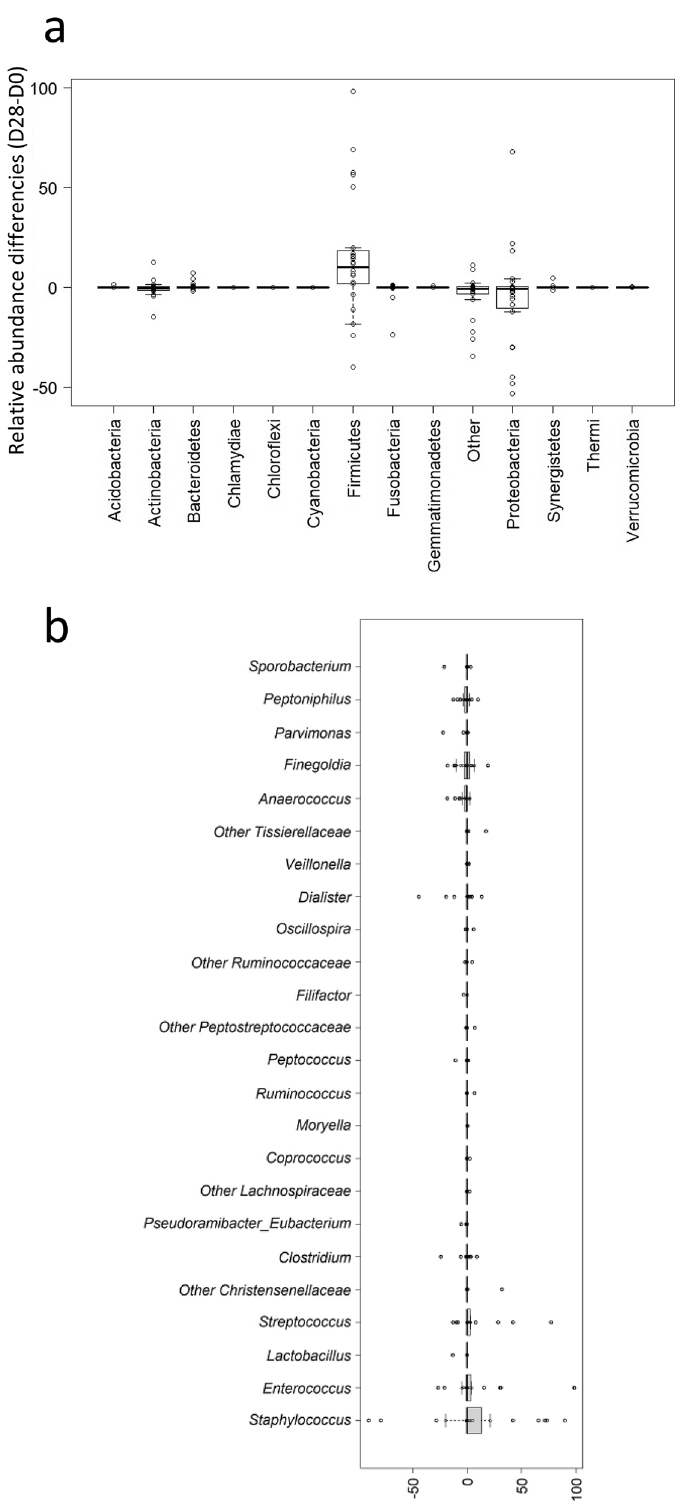
Figure 2. Evolution of bacterial microbiota isolated from wounds over time. ( a ) Boxplot of relative frequencies differences (D28-D0) of phyla (the group “Other” represents unclassified bacteria at phylum level). ( b ) Boxplot of relative frequencies differences (D28-D0) of bacteria genera. Only genera > 1% of OTUs in at least one wound and in at least one time (D0 or/and D28) and belonging to Firmicutes are